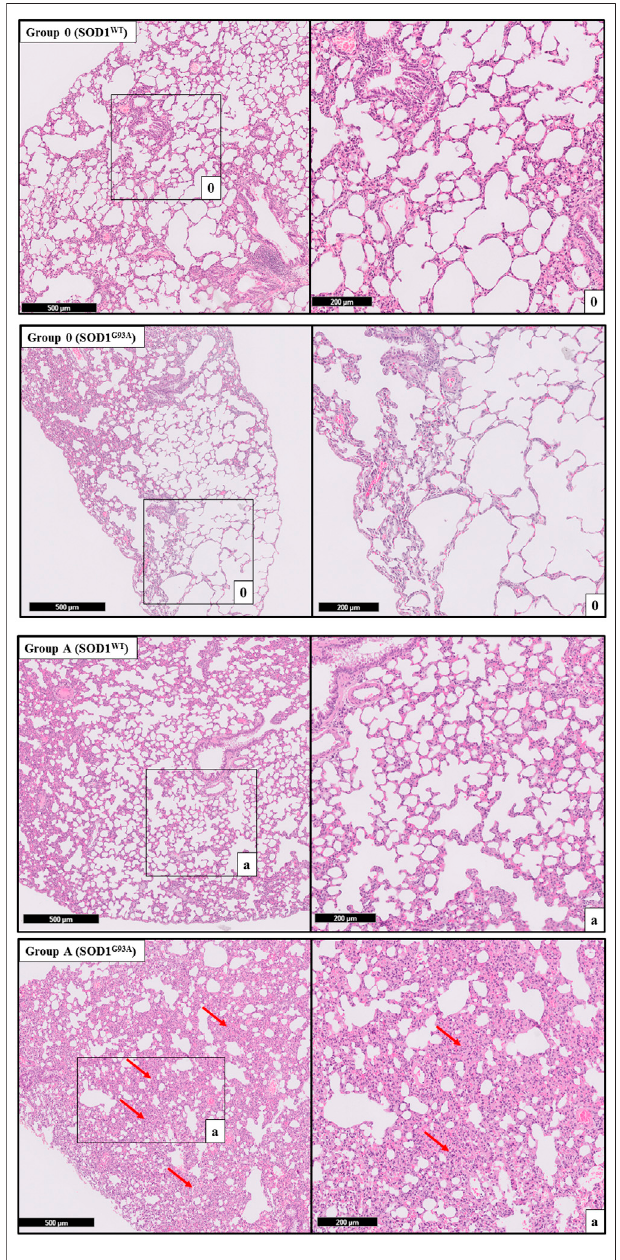
FIGURE 3 | H&E-stained lung tissue sections of lung tissues. Representative images of SOD1 G93A and SOD1 WT rats of groups 0 and A were taken from each group. Scale lines on the left row indicate 500 μ m and thesecondrow200 μ m.Redarrows indicate theareawithatelectasisof SOD1 G93A